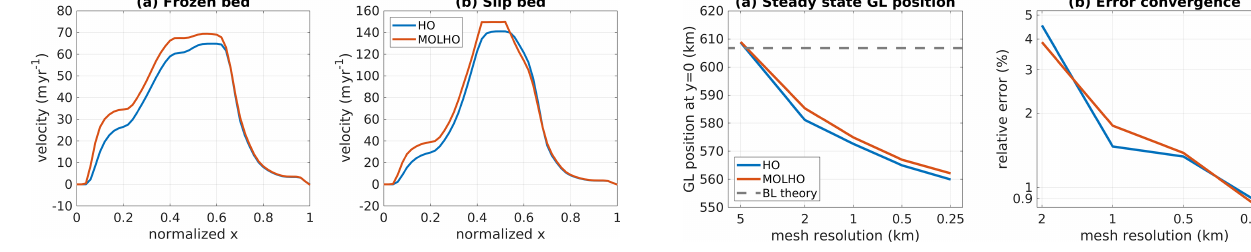
Figure 4. MISMIP3D experiment: steady-state positions (a) and es- timated error convergence (b) of the grounding line (GL) at y = 0 obtained with different mesh resolutions using HO and MOLHO. The error convergence is estimated using Eq. (24). For comparison, the steady-state grounding line position predicted by the boundary layer (BL) theory that is based on the SSA model is also